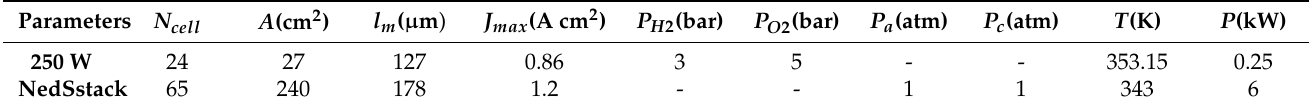
Table 2. The known parameters of